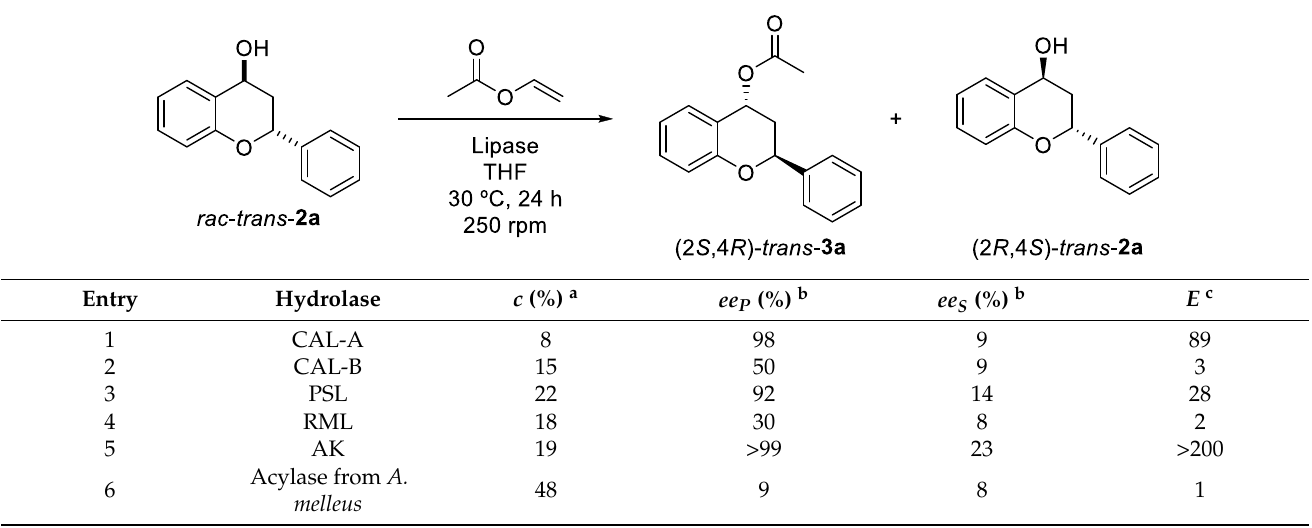
Table 3. Screening of hydrolases for the kinetic resolution of trans -flavan-4-ol ( 2a , 100 mM) using 3 equivalents of vinyl acetate in dry THF at 30 °C and 250 rpm.